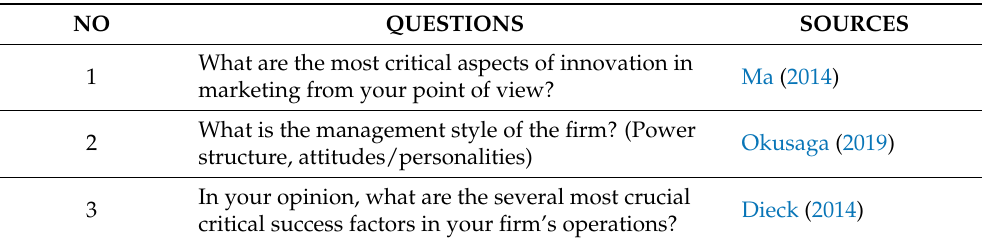
Table 2. Interview